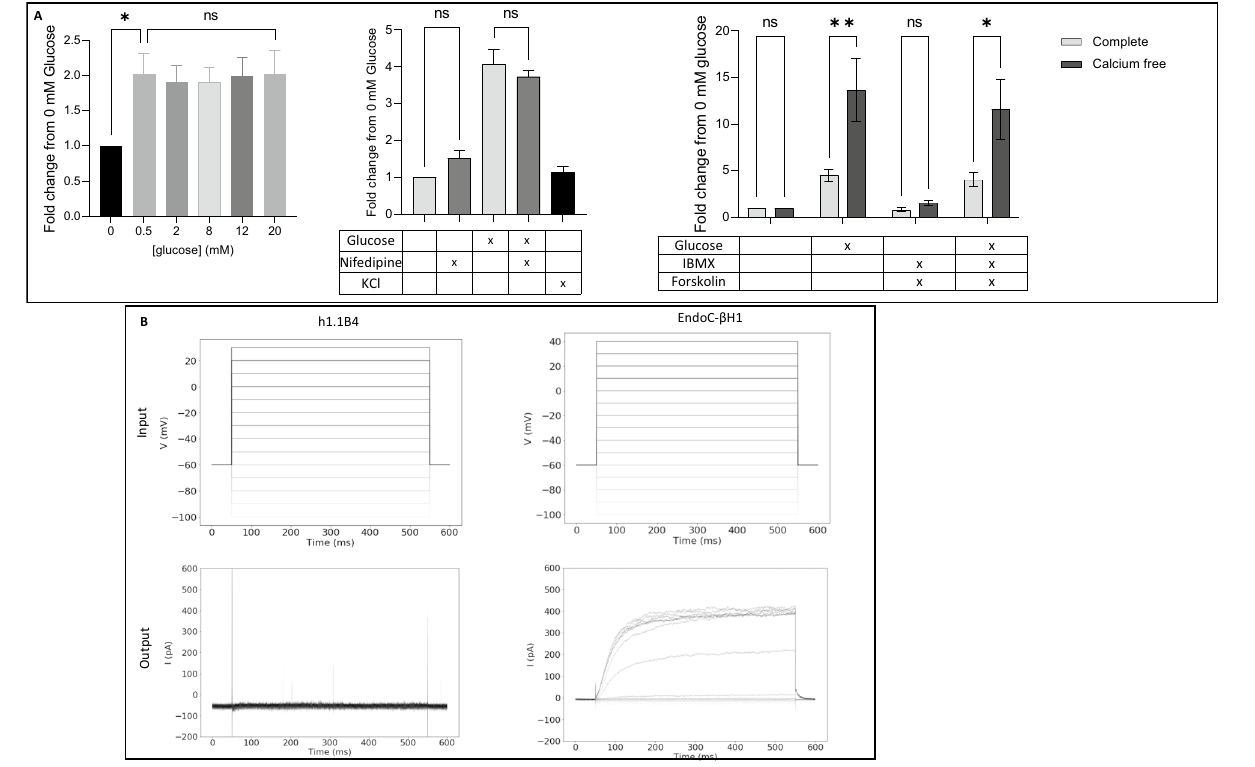
Figure 6. Secretory and electrophysiological characteristics of human 1.1B4 cells. ( A ) h1.1B4 cells (colony 1) were transfected with a plasmid encoding hGH for 48 h prior to incubation with increasing glucose concentrations (left panel); 0 or 20 mM glucose in the absence or presence of either nifedipine (1 μM) or 30 mM KCl (middle panel); 0 or 20 mM glucose in the absence or presence of 1 mM CaCl 2 , 10 μM forskolin or 100 μM 3-isobutyl 1-methyl xanthine (IBMX; right panel). P < 0.05, ** P ≤ 0.005; ns = not significant. ( B ) Whole cell patch clamp analysis was performed on h1.1B4 cells (colony 1) and EndoC-βH1 cells and the current flow